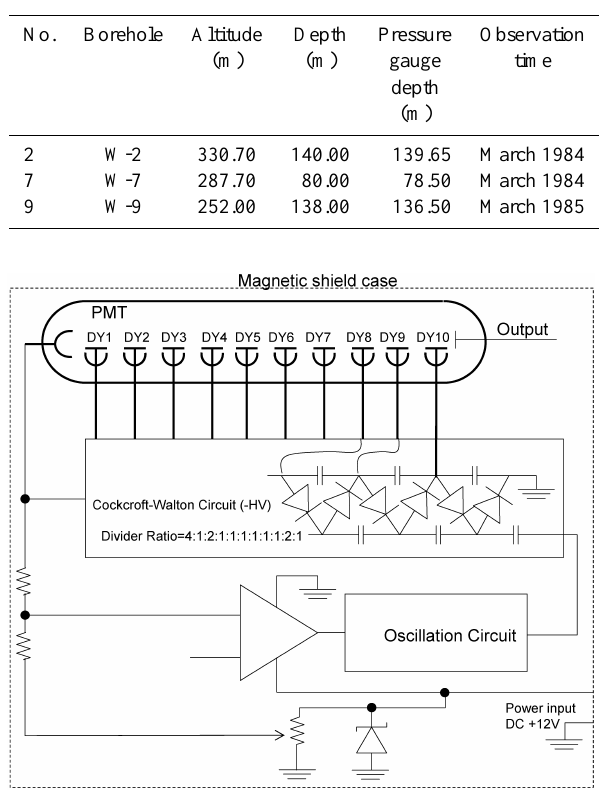
Fig. 4. Block diagram of the Cockcroft–Walton photomultiplier.